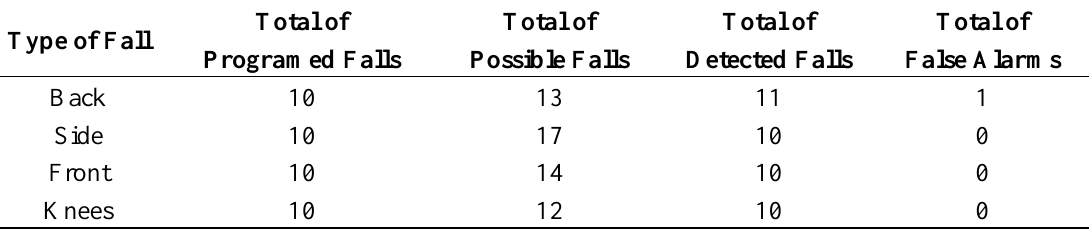
Table 3. Generated DATA packets from falls.